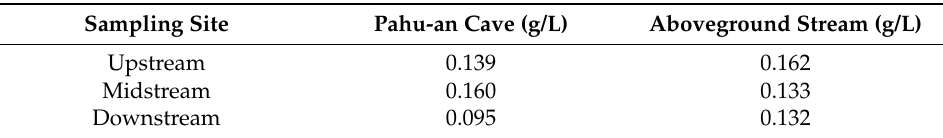
Table 8. Total suspended solids